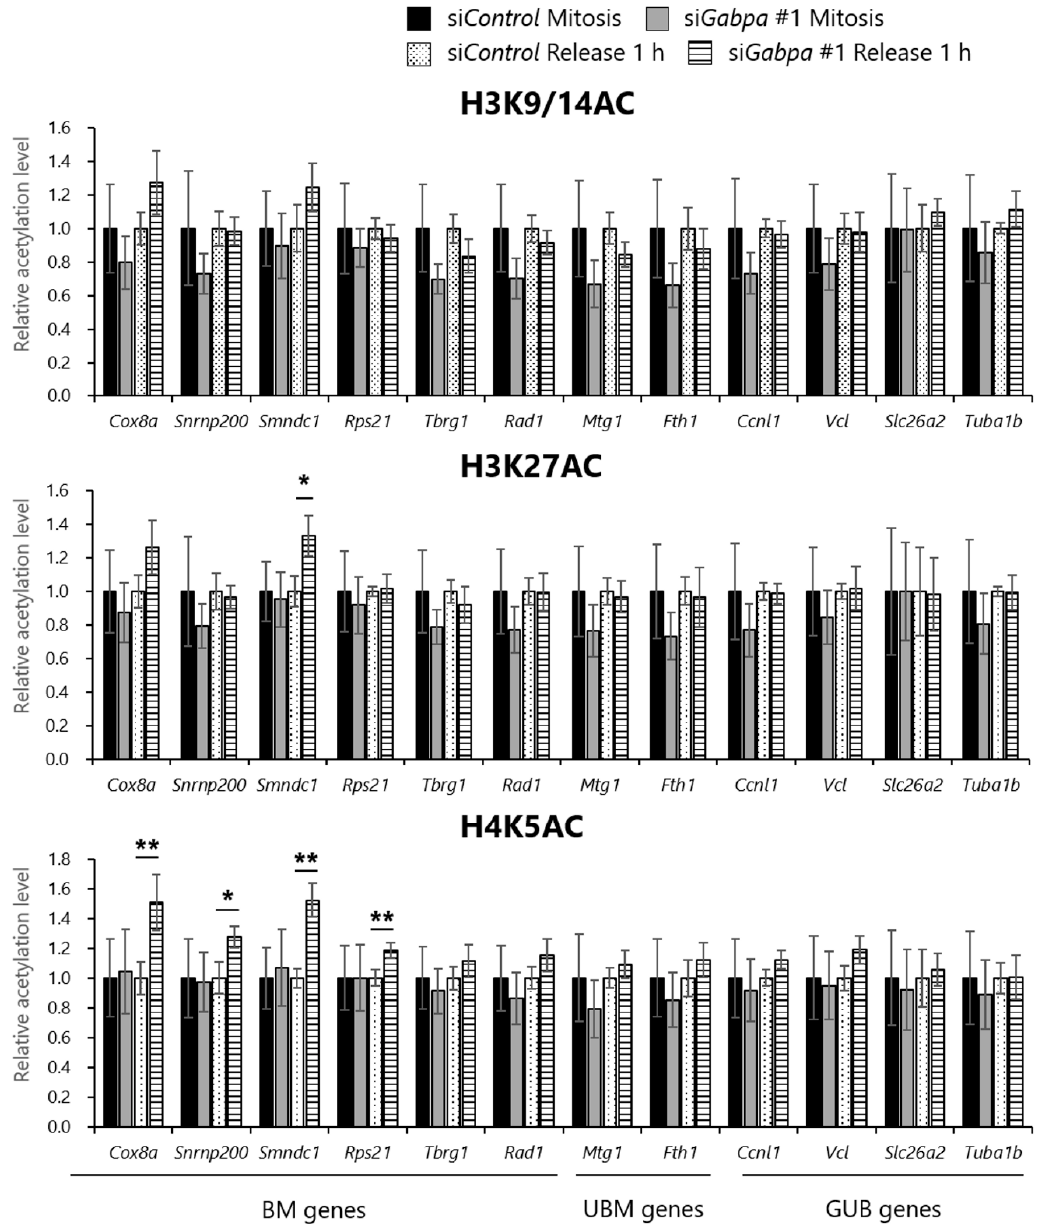
Figure 4. Gabpa knockdown initially increases H4K5 acetylation level at bookmarked genes in